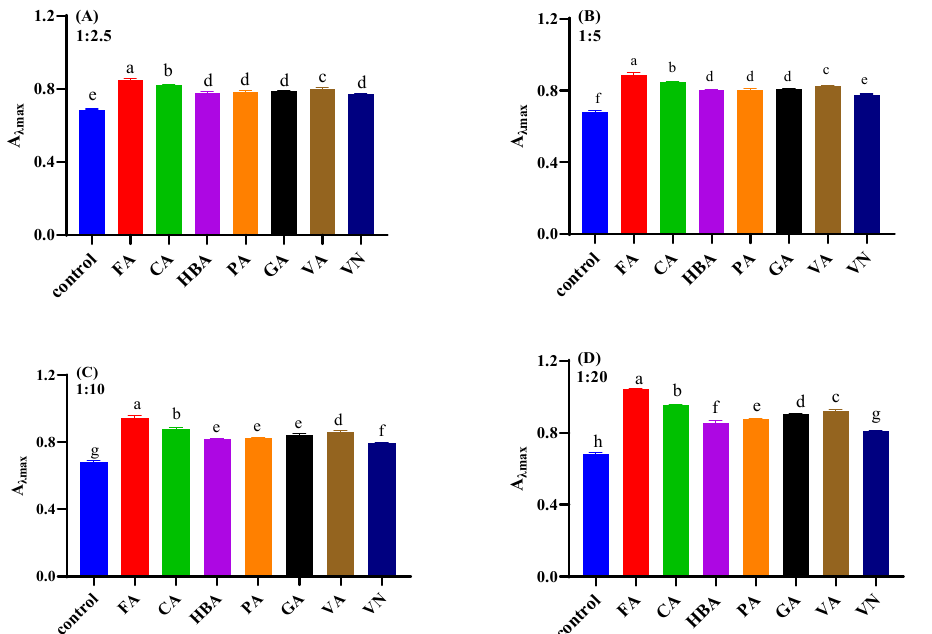
Figure 2. The A λ max of the mulberry anthocyanin co-pigmentation at different molar ratio (( A ) an- thocyanin: co-pigments 1:2.5; ( B ) anthocyanin: co-pigments 1:5; ( C ) anthocyanin: co-pigments 1:10; ( D ) anthocyanin: co-pigments 1:20). Different letters indicate significant differences between samples ( p < 0.05).